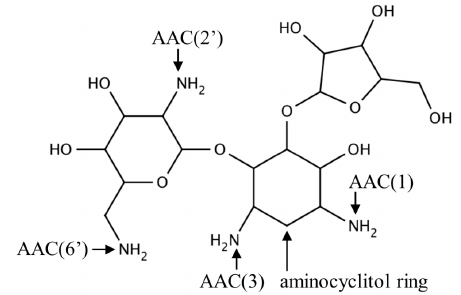
Figure 2. Chemical structure of an aminoglycoside antibiotic (ribostamycin) showing the central aminocyclitol ring and acetyl group modification sites (1, 2 ′ , 3 and 6 ′ ). Aminoglycoside 2- N -acetyltransferase-Ic of Mycobacterium tuberculosis (MtAAC(2 ′ )-Ic) can perform both N - and O -acetylation of the 2 ′ amino group of a wide range of aminoglycoside antibiotics [22]. MtAAC(2 ′ )-Ic is a 20.0 kDa protein encoded by the chromosomal Rv0262c gene [23].